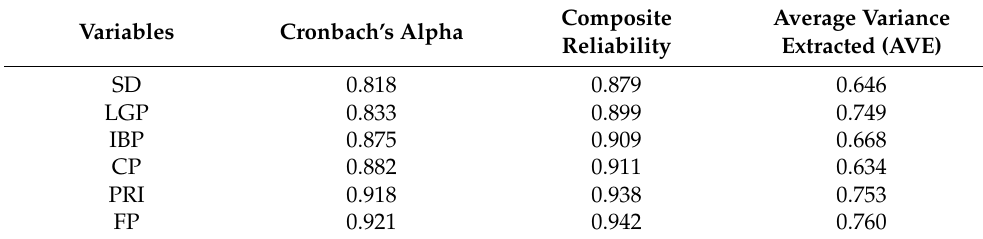
Table 3. Reliability.